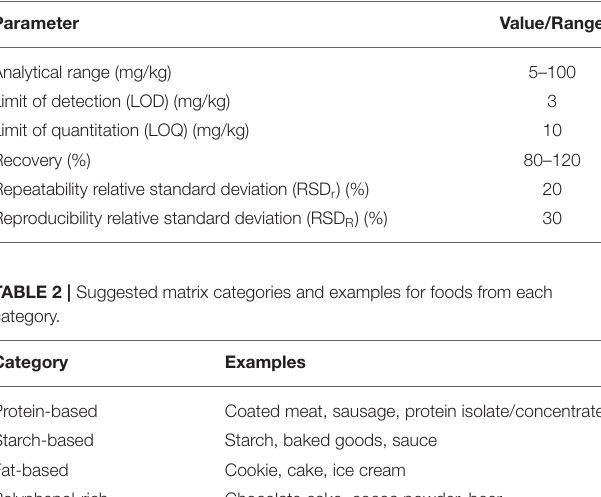
TABLE 1 | Method performance requirements for gluten ELISAs.